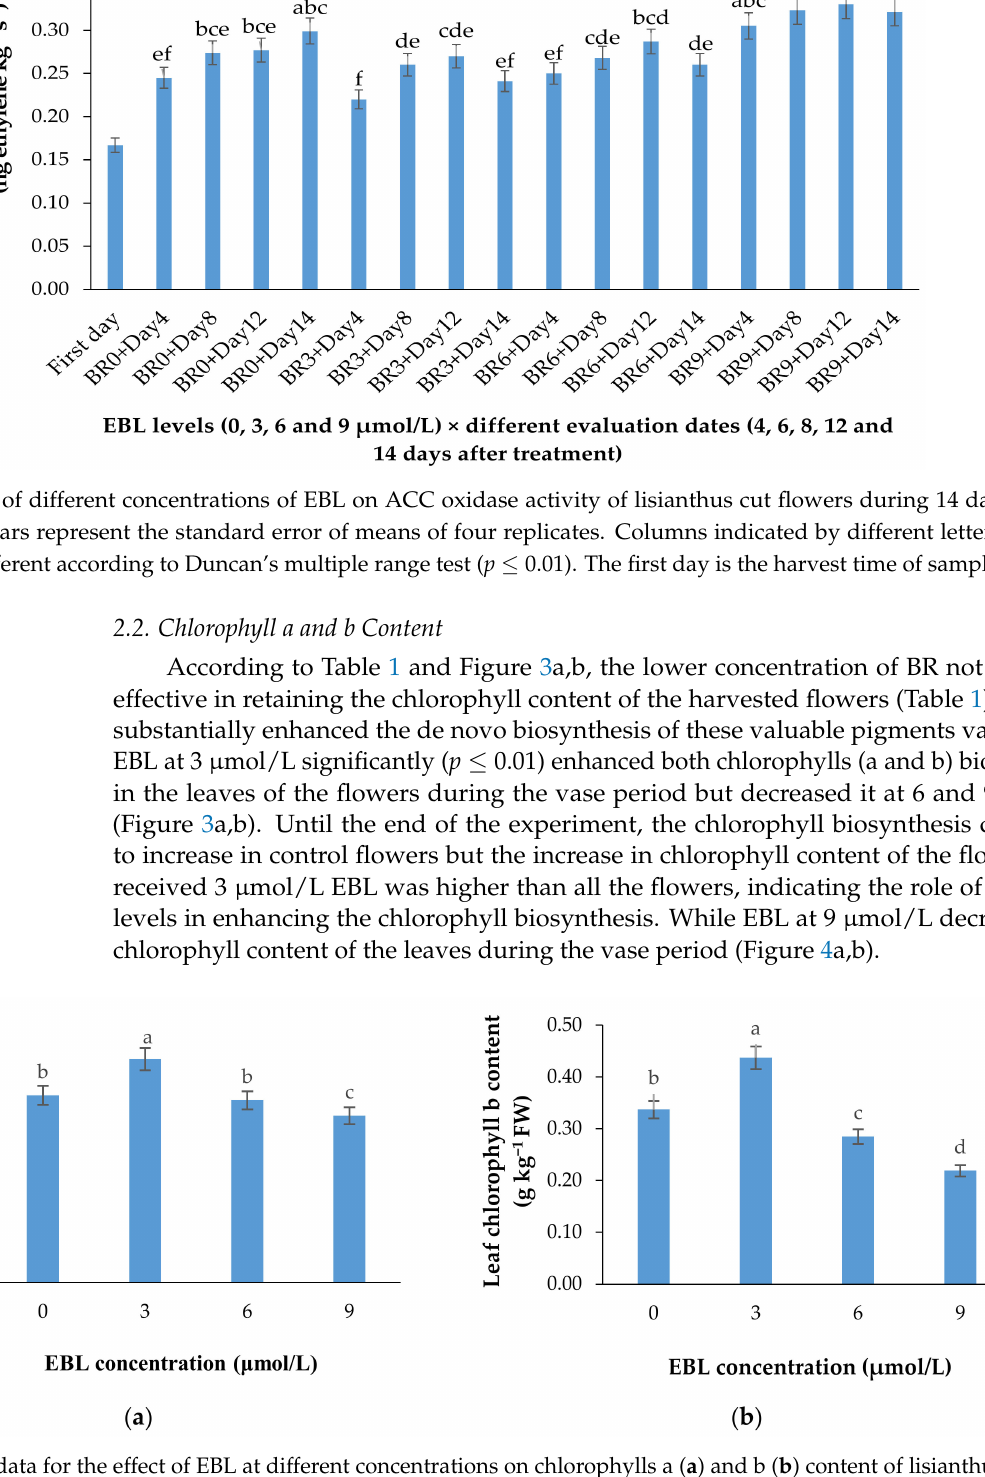
Figure 3. Mean data for the effect of EBL at different concentrations on chlorophylls a ( a ) and b ( b ) content of lisianthus cut flower leaves. Error bars represent the standard error of means of four replicates. Columns indicated by different letters are significantly different according to Duncan’s multiple range test ( p ≤